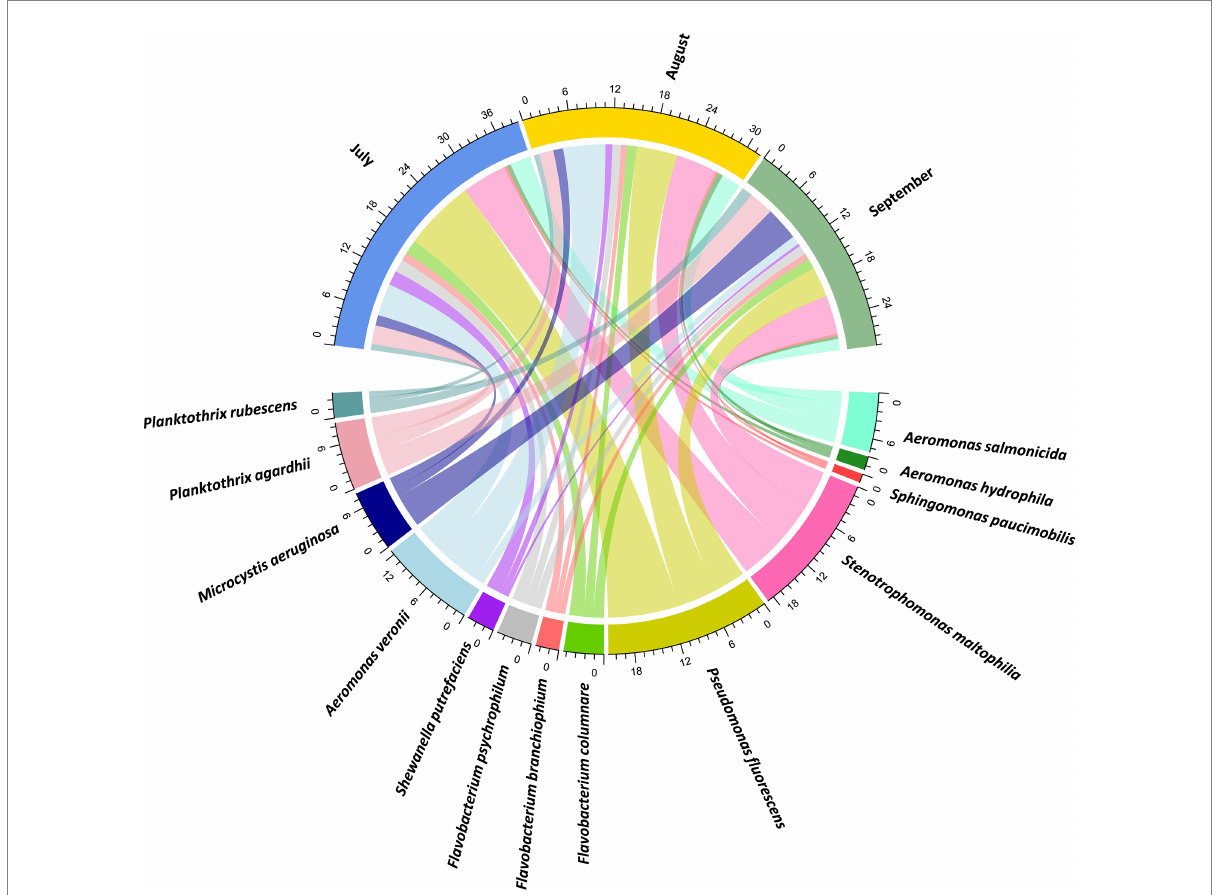
FIGURE 5 Chord diagram showing the distribution of bacterial species that have been reported as pathogenic for fish. The numbers around the circumference represent the percentage of relative abundance coverage of the bacterial species by sampling month in Lake